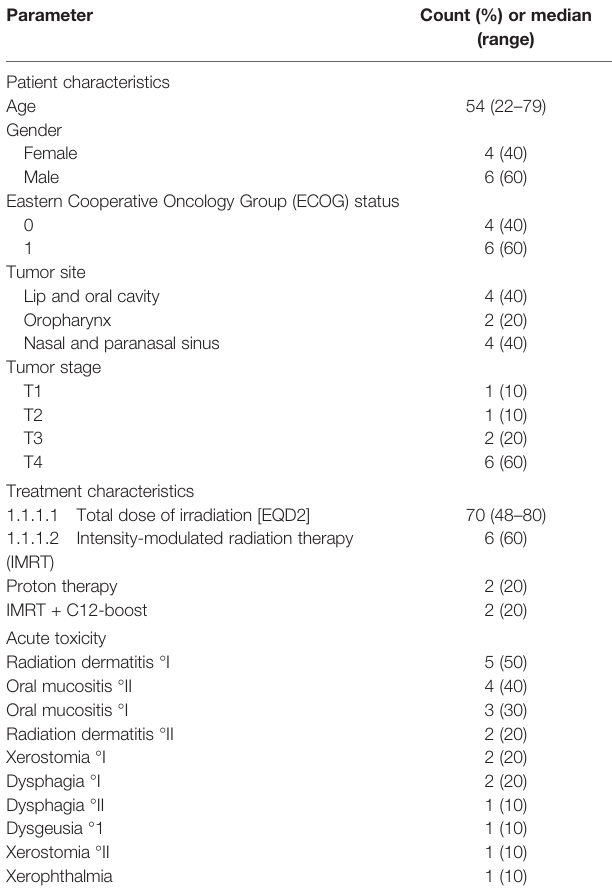
TABLE 2 | Patient and treatment characteristics and acute treatment-related toxicity (n = 10